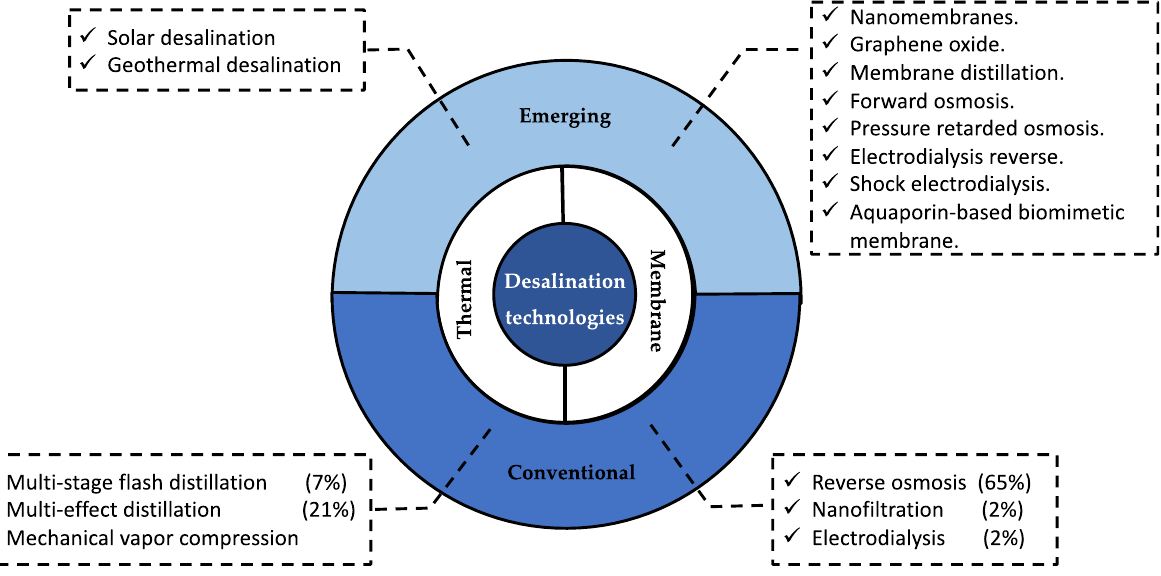
Figure 1. Schematic classification of desalination technologies.